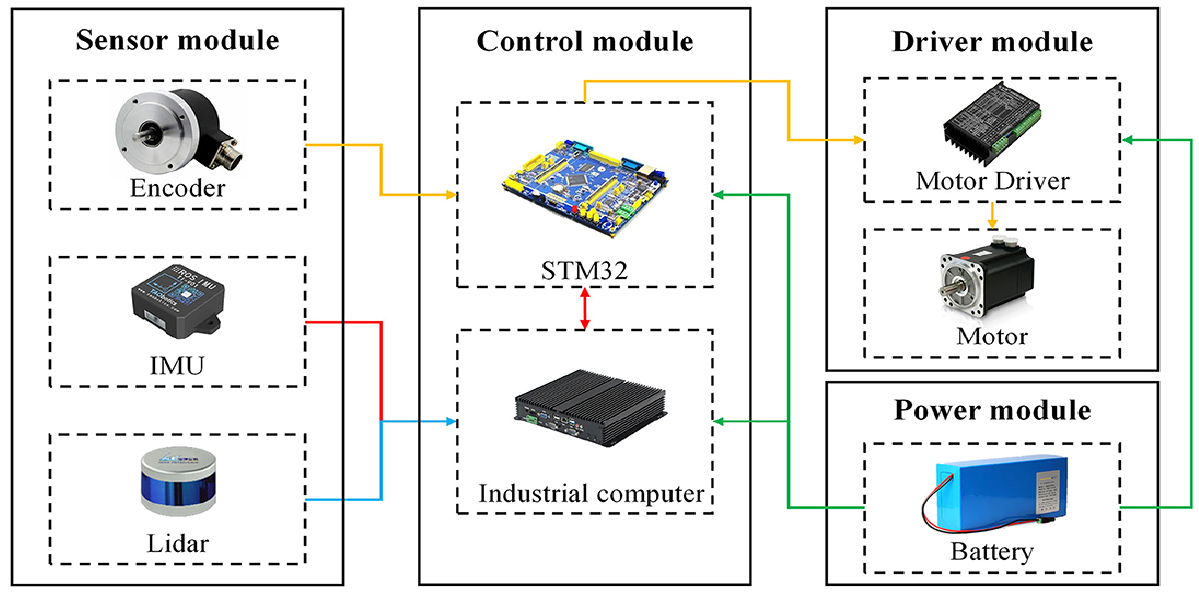
Figure 14. Hardware structure for the navigation of wheeled mobile robots [91].